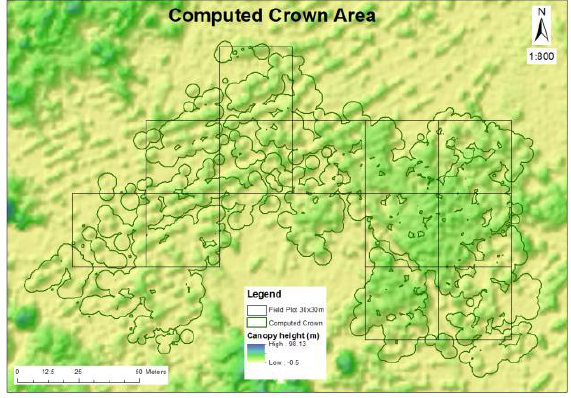
Figure 4. Computed crown area for all 1416